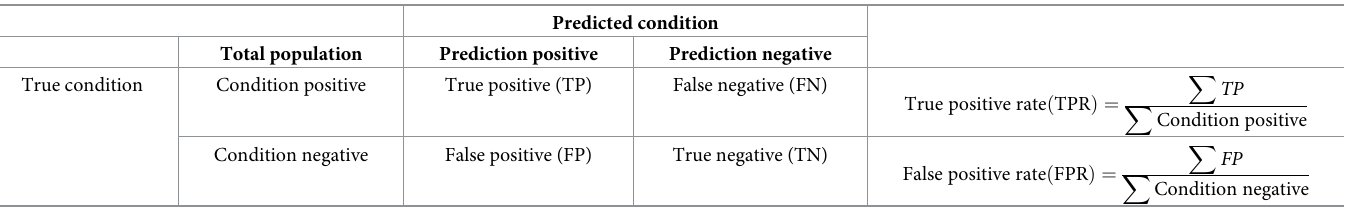
Table 1. Confusion